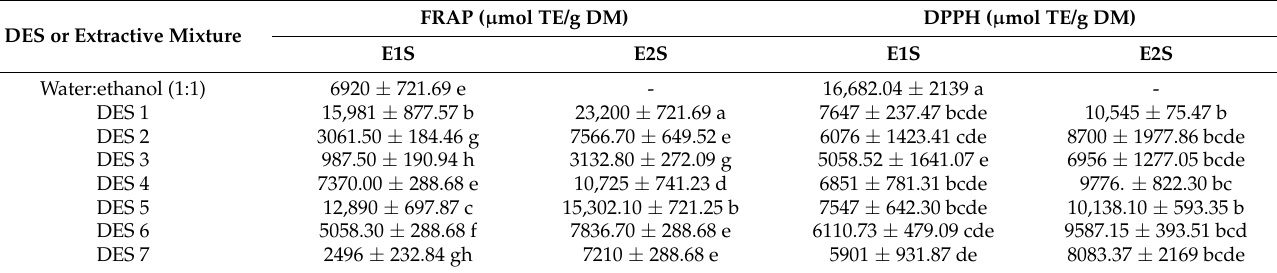
Table 9. Antioxidant